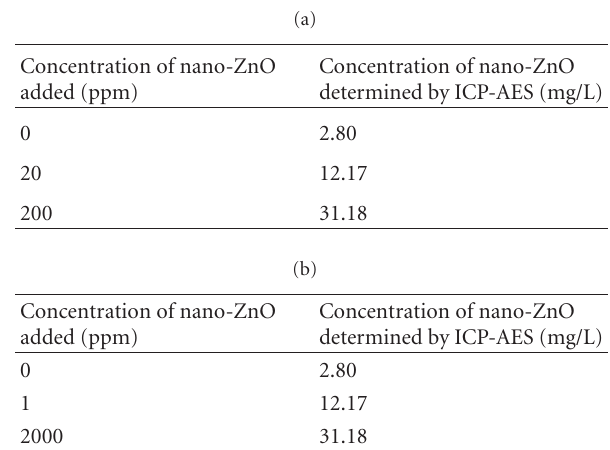
Table 1: Weight of zinc element in (a) mung and (b) gram seedling roots determined by